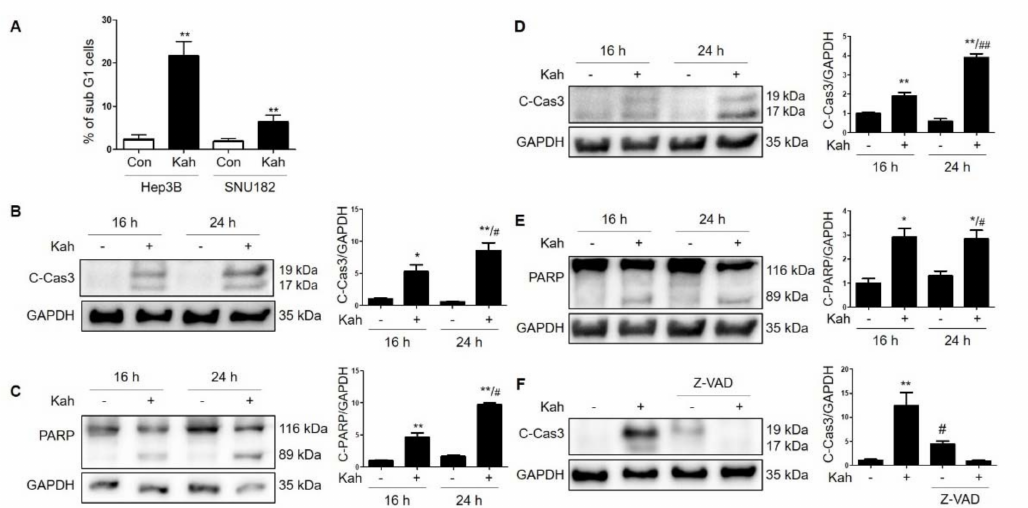
Figure 3. Kahweol induces apoptosis in HCC cells. ( A ) HCC cells were treated with kahweol (40 µ M) for 24 h. Apoptotic cells (a sub-G1 population) were identified using flow cytometry. ** p < 0.01 relative to control. Western blot analyses of ( B , D ) cleaved caspase 3 ( B , Hep3B cells; and D , SNU182 cells) and ( C , E ) cleaved PARP ( C , Hep3B cells; and E , SNU182 cells) in HCC cells treated with kahweol. Data in the graph are represented as the mean ± SEM of three independent measurements, and graphs are normalized to 16 h control (without kahweol). * p < 0.05 and ** p < 0.01 relative to the 16 h control. # p < 0.05 and ## p < 0.01 relative to the 24 h control (without kahweol). ( F ) Hep3B cells were treated with kahweol for 24 h in the presence or absence of Z-VAD-fmk (20 µ M). Data in the graph are represented as the mean ± SEM of three independent measurements. ** p < 0.01 relative to control and # p < 0.05 relative to